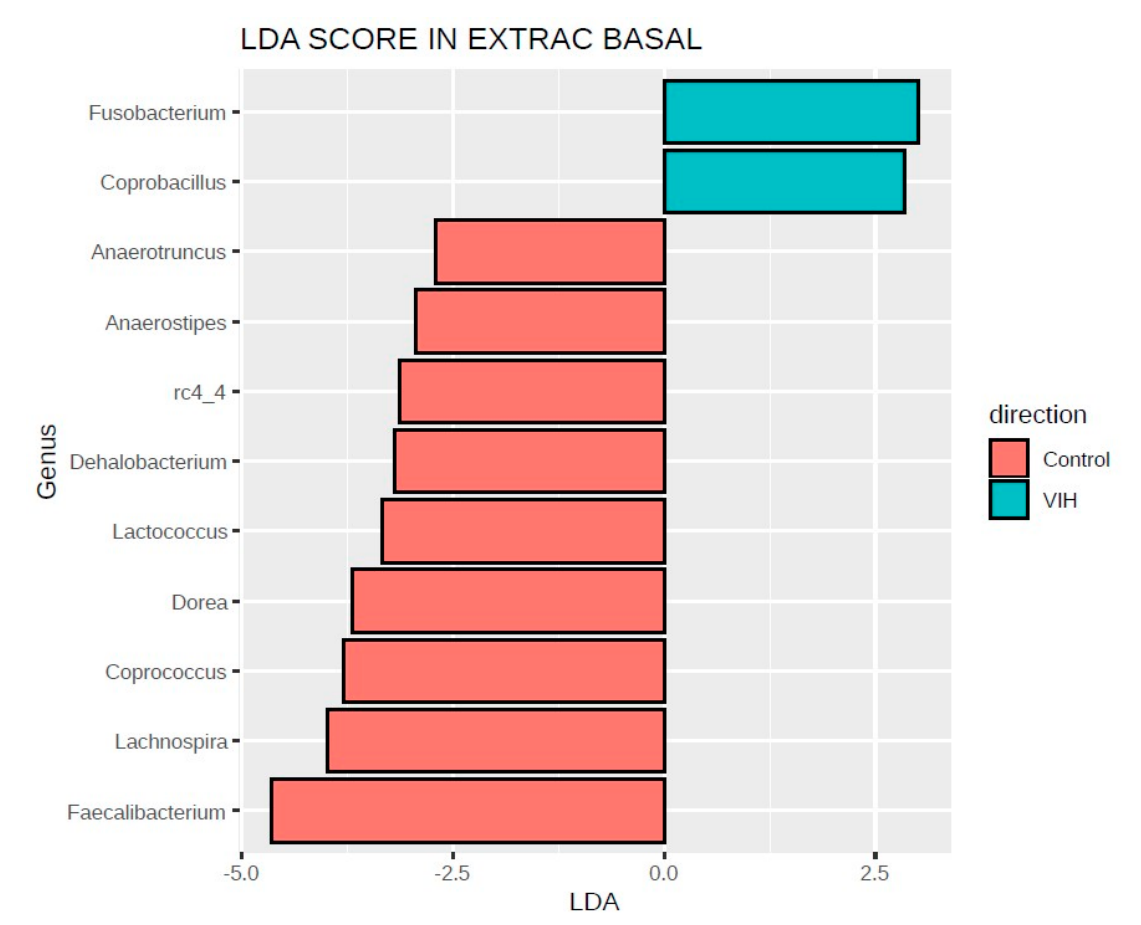
Figure 4. Bacterial taxa driving divergences between groups using LEfSe analysis, HIV-infected children vs. controls at baseline. The analysis week 0 vs. week 4 samples from HIV-infected subjects in the PMT25341 arm did not identify any significant change in the abundance of bacterial genus. The linear discriminative analysis (LDA) scores (log 10) for the most prevalent taxa among controls, represented in red, are plotted in the positive scale, whereas LDA-negative scores indicate those taxa enriched in the HIV-infected group at baseline or after the intervention are represented in green.